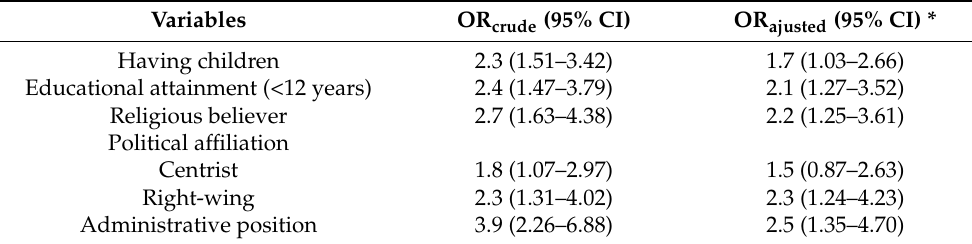
Table 3. Multiple logistic regression model for